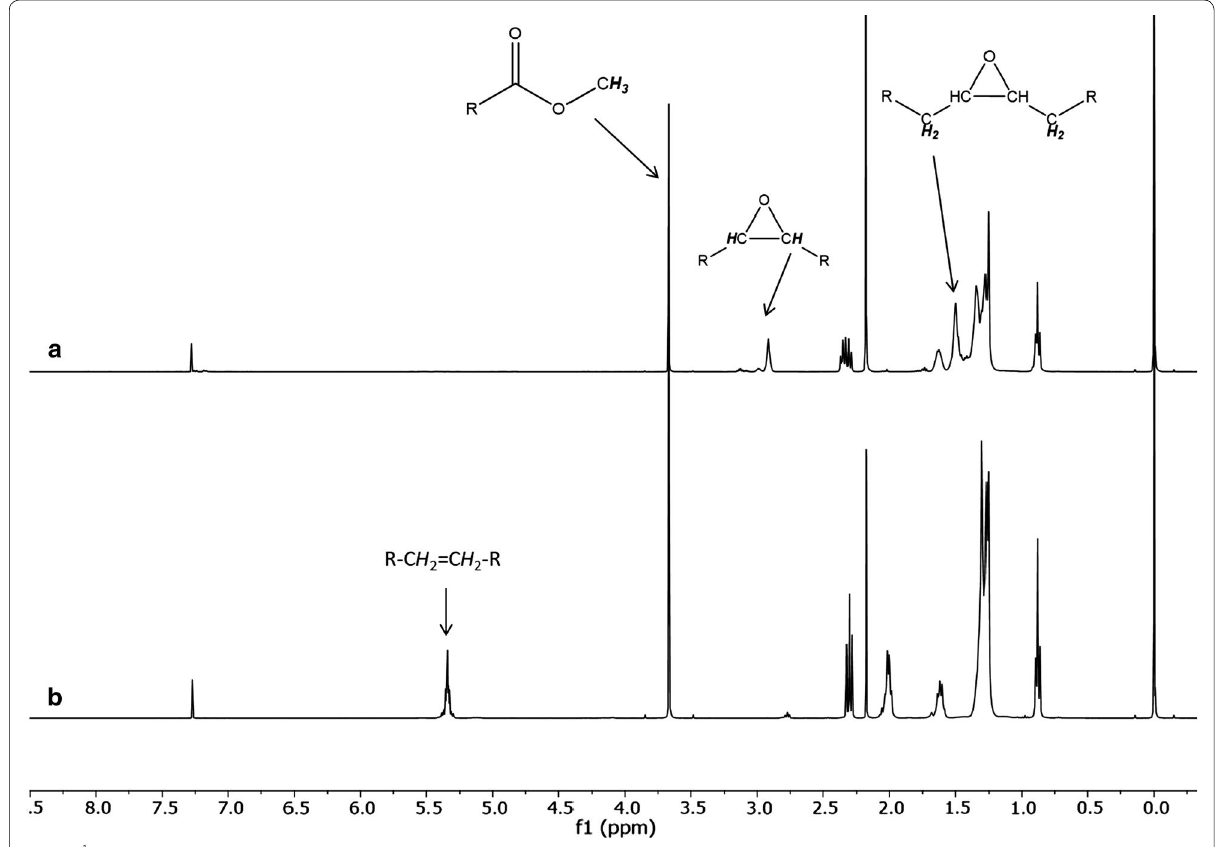
Fig. 2 1 H‑NMR spectrum of a olive epoxide and b FAME olive